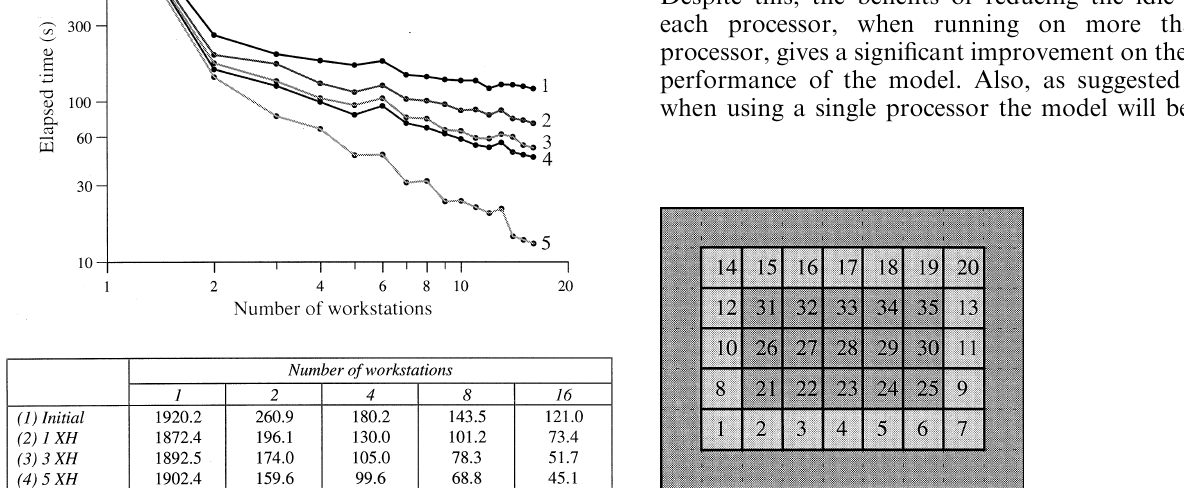
Fig. 6. Reordering the way in which the horizontal grid points are parsed, so that the boundary halo (numbered 1–20) is completed first, allows the communication of this boundary data to be overlapped with the calculation of the remaining inner grid